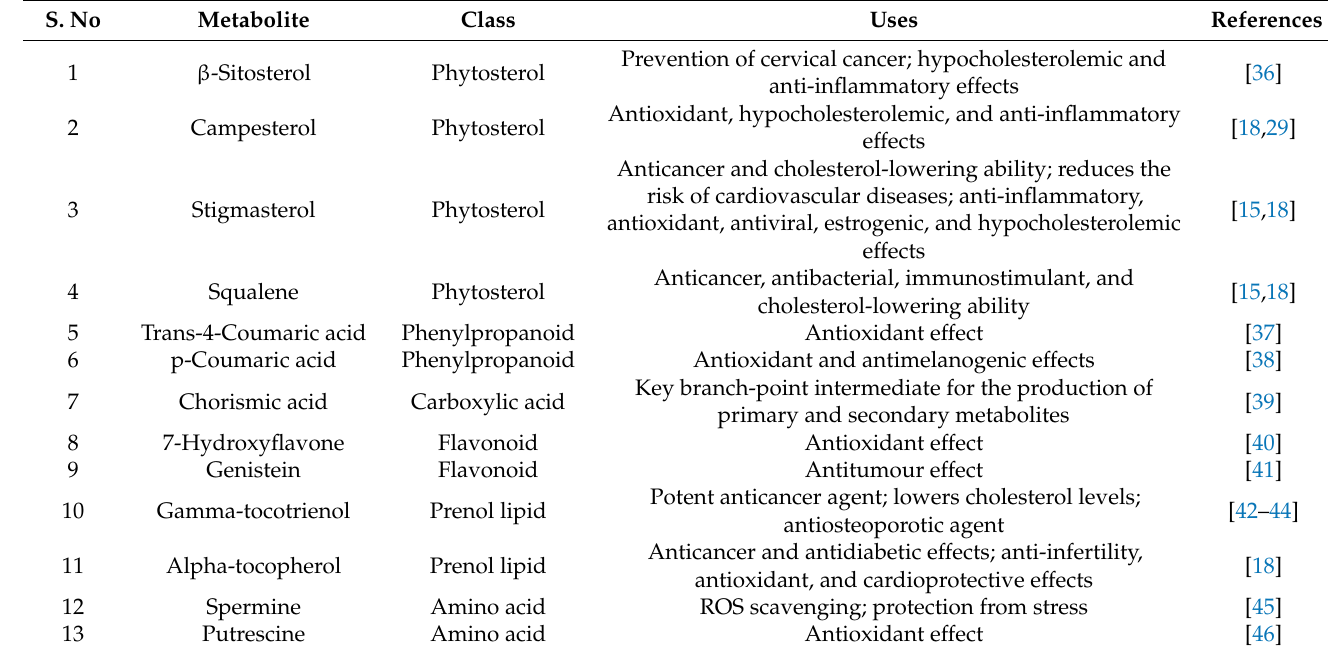
Table 4. List of significant nutraceutical and therapeutic metabolites in Mappillai Samba and their potential